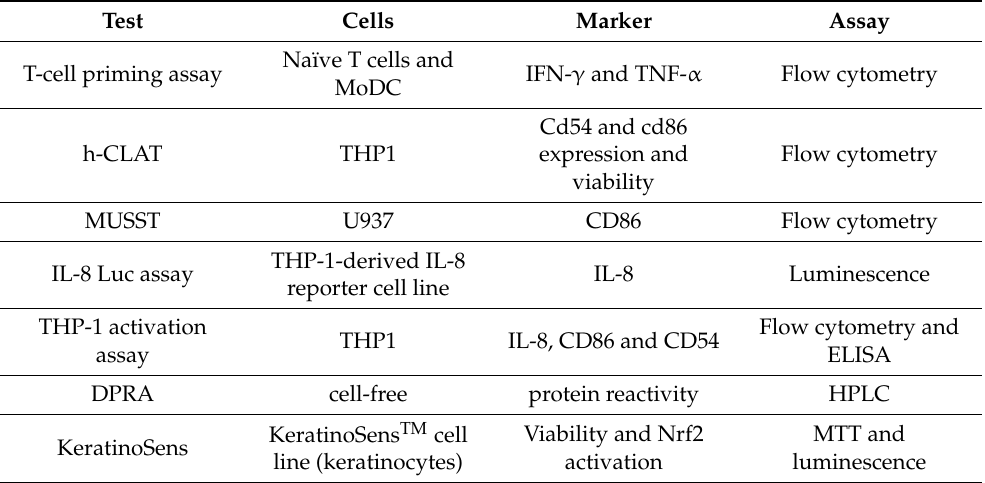
Table 3. In vitro preclinical assays described for the study of sensitizing substances. Test Cells